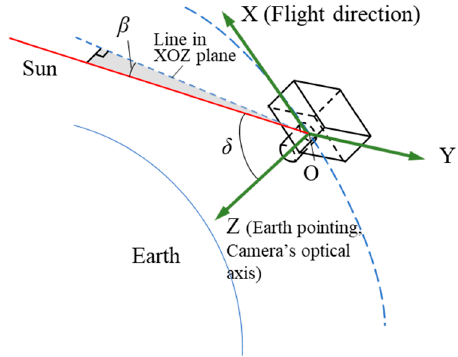
Figure 4. Layout of solar vector.